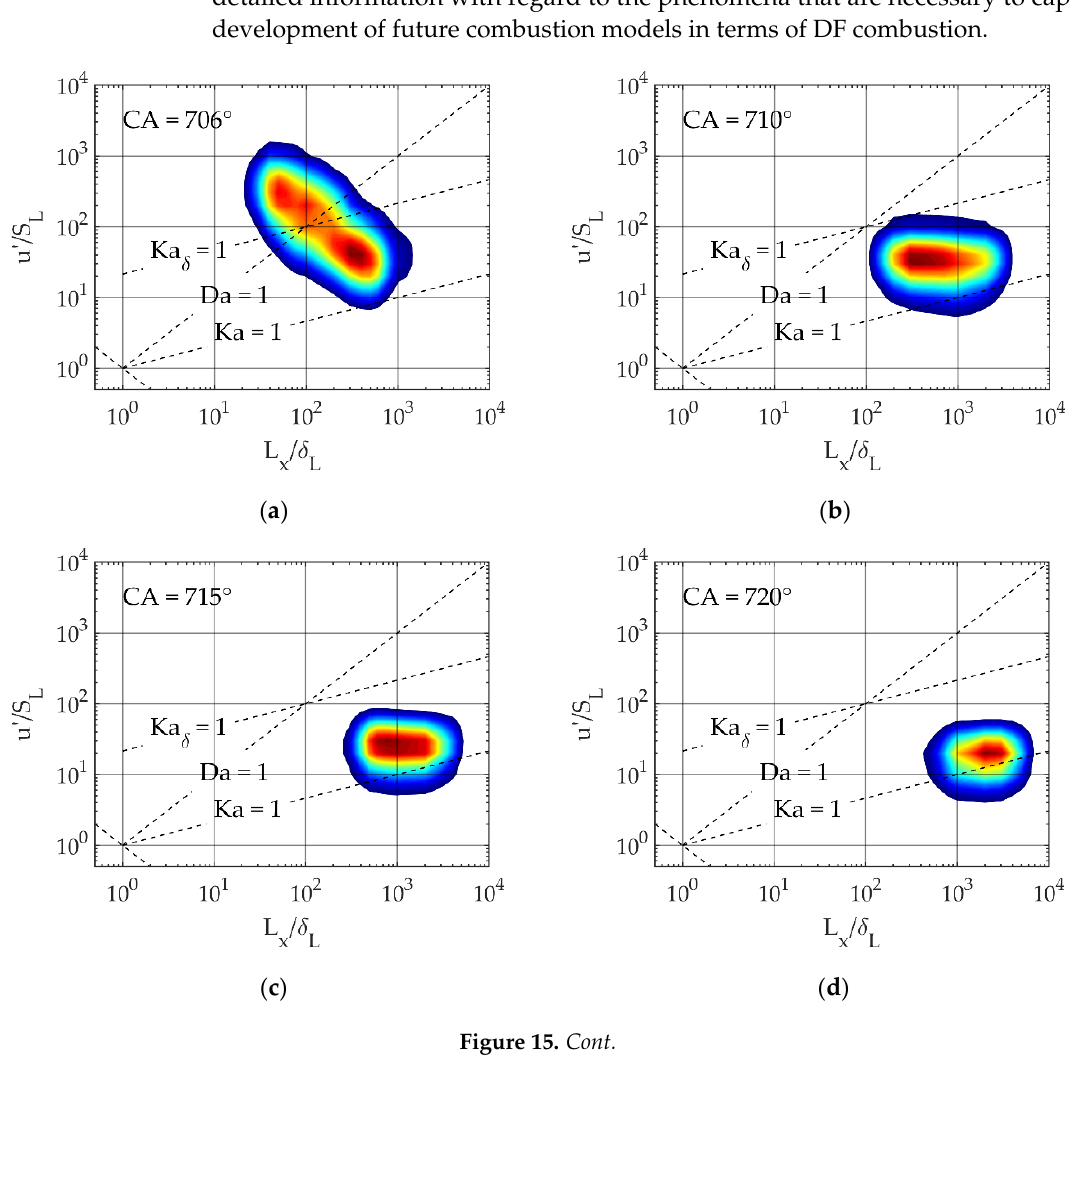
( f ) Figure 15. Volume-based probability of the combustion regimes present in the evaluated area in front of the flame for a crank angle of 706° ( a ), 710° ( b ), 715° ( c ), 720° ( d ), 730° ( e ) and 740° ( f ). 4.3. Cycle-to-Cycle Variations In this subsection, the occurrence of CCVs and their possible origins are addressed in detail. CCVs depict an important factor in ensuring stable engine operation and should be kept as low as possible. There are many different reasons for the occurrence of CCVs in terms of DF combustion that the present study in its entirety cannot investigate. The focus here was on the impact of the turbulent fluctuations of the in-cylinder flow on flame propagation. As mentioned in [7], the pilot injection is also a possible source of CCVs due to strong varying conditions at the nozzle exit. However, this was not considered in the present study. A crucial factor for CCVs is the interaction of the turbulence with the pilot spray and the flame front. The influence of the turbulence on the peak pressure and thus the com- bustion speed can be clarified by evaluating the RMS velocities of the in-cylinder flow in the three spatial directions. Figure 16a illustrates the peak pressure’s dependence on the RMS velocity in the x-direction U rms . A certain correlation between the increase in the RMS velocity and the peak pressure can be found. This correlation becomes more obvious in Figure 16b, where the RMS velocity in y-direction V rms is evaluated. A distinct correlation is present in terms of the RMS velocity in z-direction W rms depicted in Figure 16c. This observation may result from the turbulence generated by the fluctuations of the squish